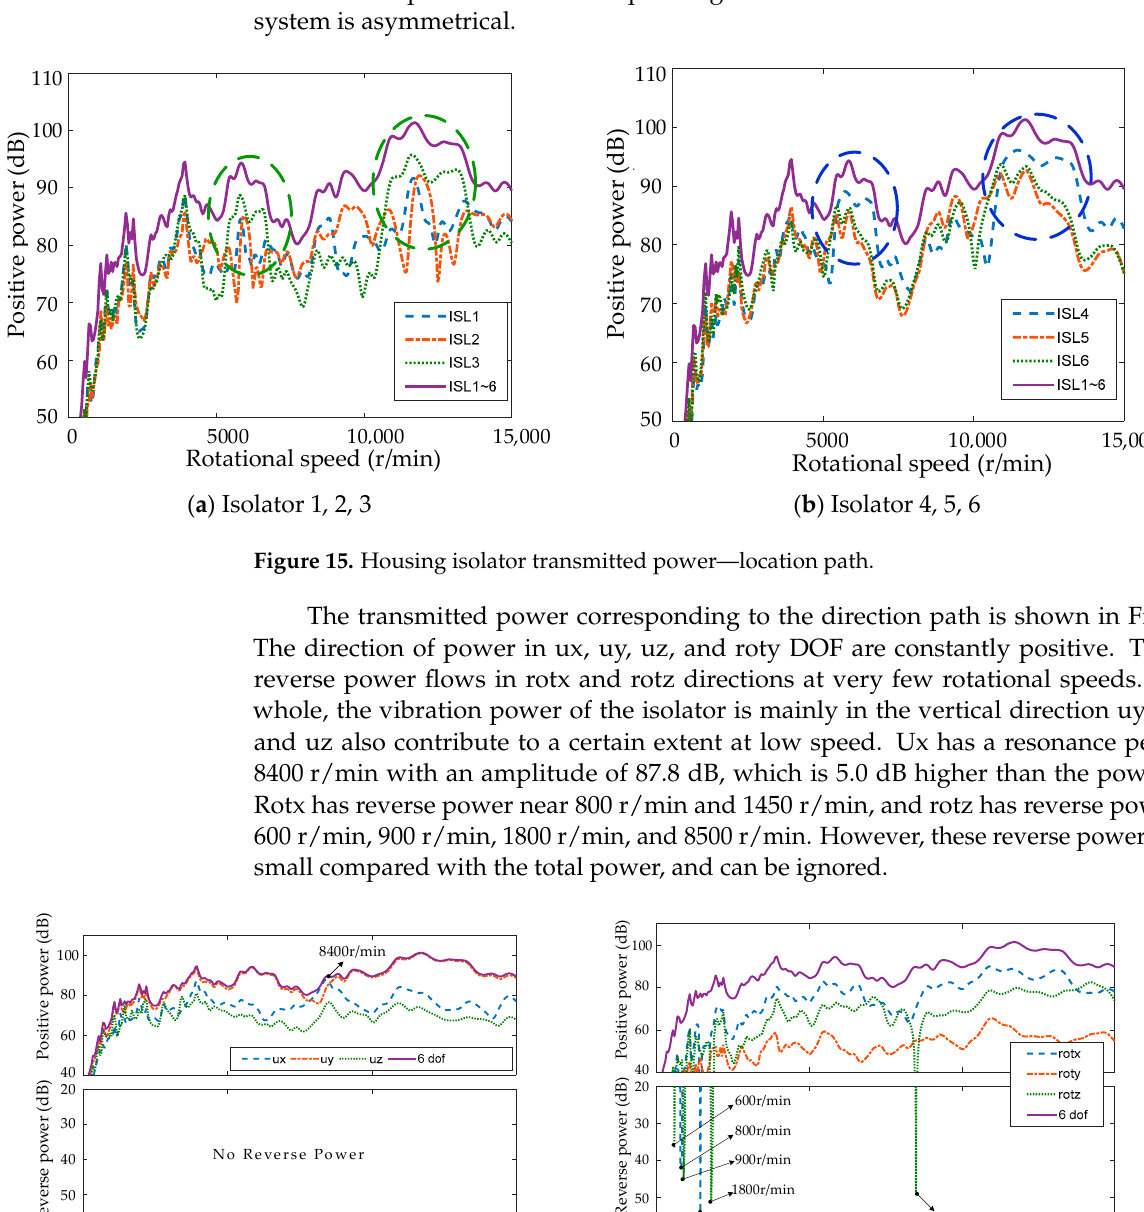
Figure 16. Housing isolator transmi tt ed power—direction path